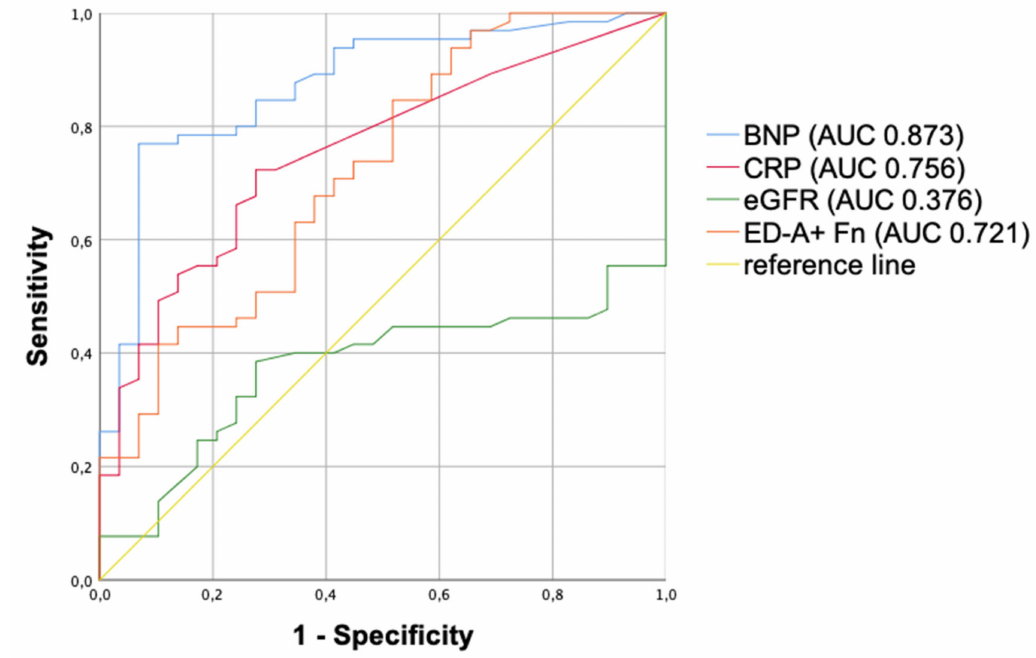
Figure 4. ROC curves to distinguish between PH patients and healthy controls, including AUC values for ED-A + Fn, BNP, CRP and eGFR. ROC: receiver operating characteristic, BNP: brain natriuretic peptide, CRP: C reactive protein, eGFR: estimated glomerular filtration rate, PH: pulmonary hypertension, AUC: area under the curve, p -value: level of